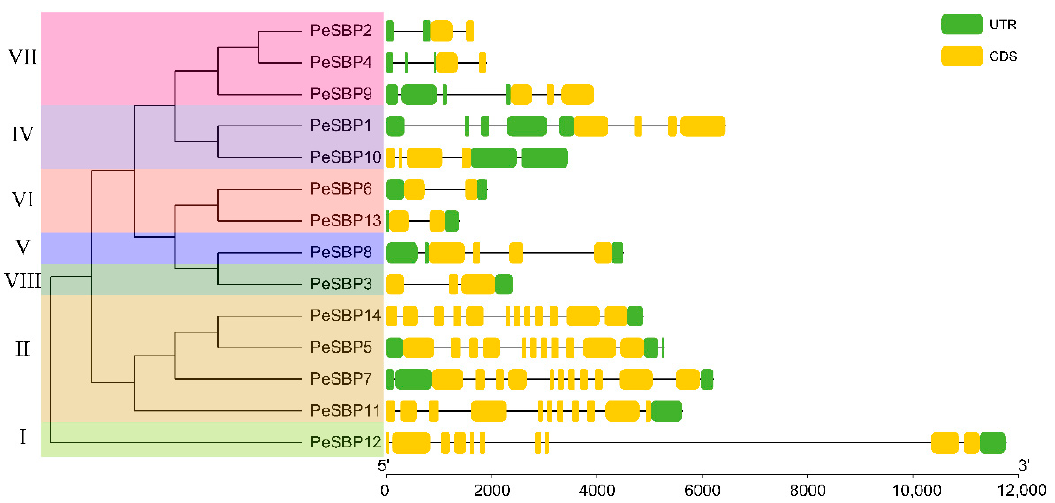
Figure 4. The exon–intron structure of SBP genes in passion fruit. The yellow round-corner rectangle represents CDS, the black shrunk line represents introns, and the green round-corner rectangle represents UTR.